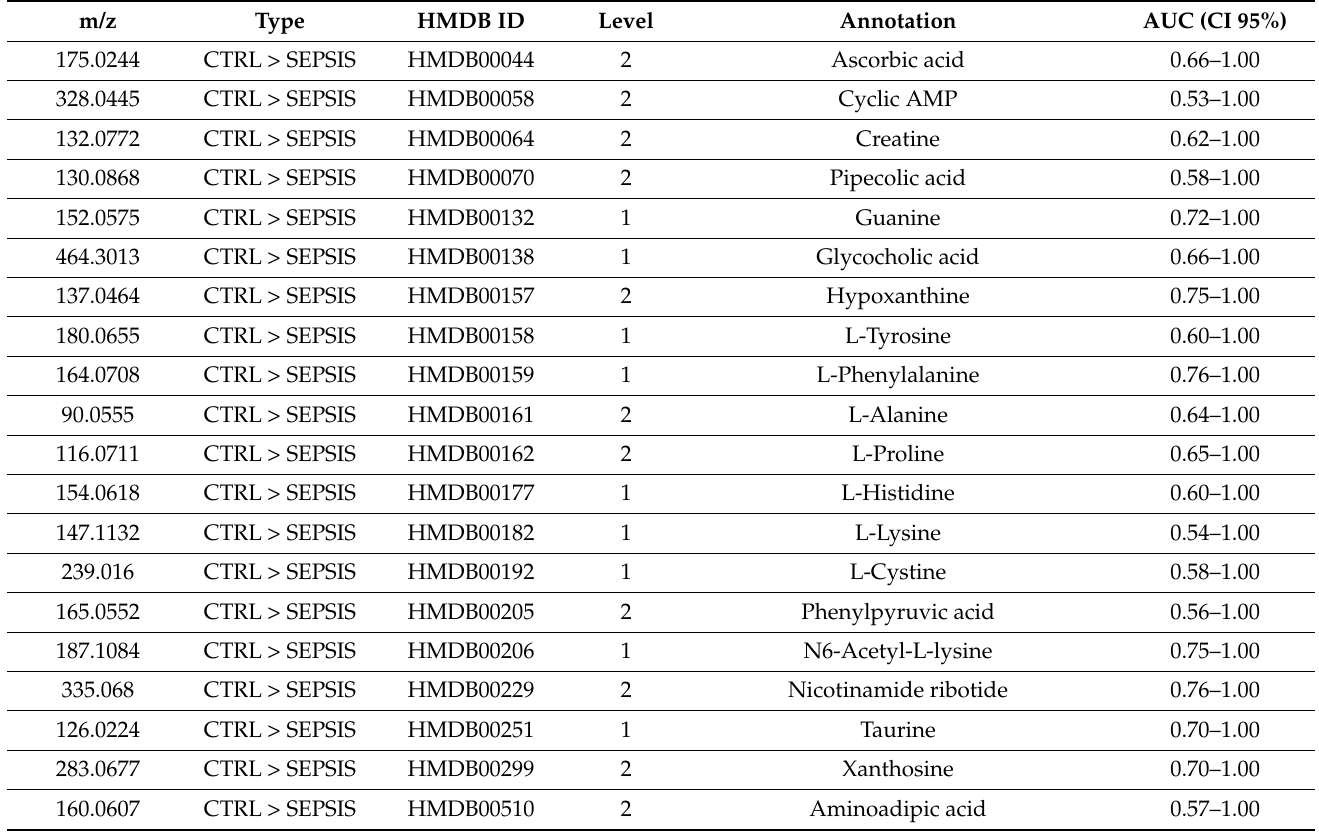
Table 2. Annotated variables. Type: CTRL > SEPSIS indicates that the mean was higher in the control group than in the earlyonset sepsis (EOS) group; SEPSIS > CTRL indicates that the mean was higher in the EOS group than in the control